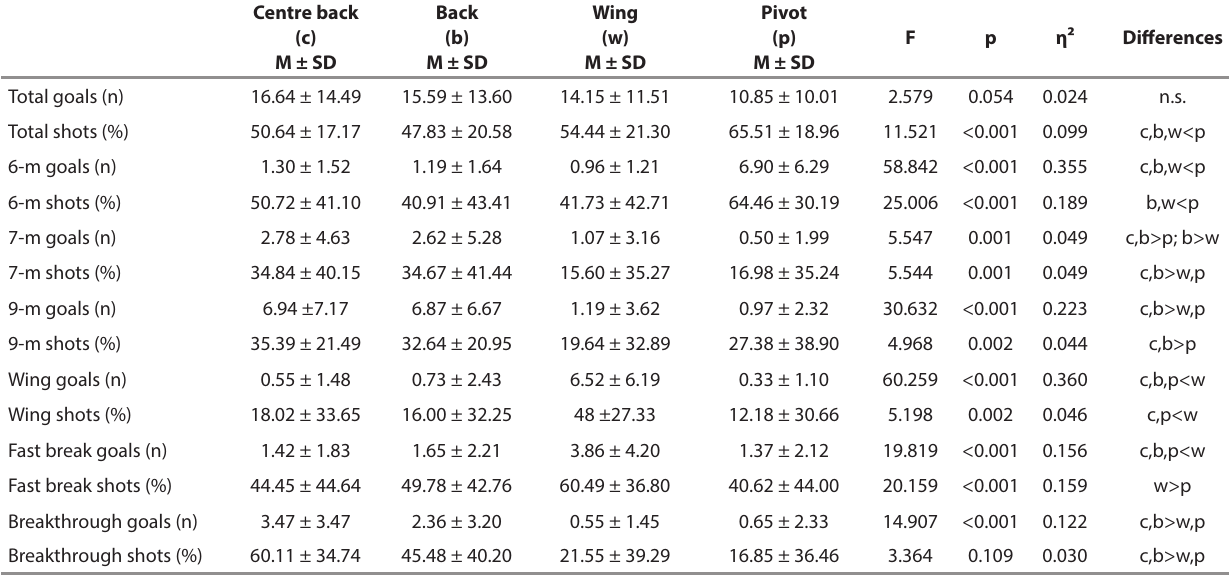
only on the year of birth, with the teams classified from 1st to 8th place having older players than the teams classified from 9th to 24th (Table 3). This seems to highlight the relevance of the players’ experience for the team’s final classification (González, 2004). Some studies, however, have indicated that both men and women players from Q1 (born in January-March) tend to play more games (Bjørndal et al., 2018) and more time per game (Leonardo et al., 2018) than those born in the subsequent trimesters. No relationship was found between RAE and the player’s position or goals scored. This does not agree with previous studies which have found differences in men (U19) at the international level, with there being greater representation of backs and wings born in the first and second trimesters (Fonseca et al., 2019) or in the first semester (Karcher et al., 2014). Another recent study (Alsharji, 2019) suggests that this RAE is also present in goalkeepers and centre back players. Regarding the differences in the goals scored and shooting effectiveness depending on the classification, there were no such differences between the teams classified from 1st to 4th place and those classified from 5th to TABLE 5. Mean and standard deviation of each variable. A one-way analysis of variance (ANOVA) with Tukey posthoc test was used to compare means between player positions. Eta squared is also